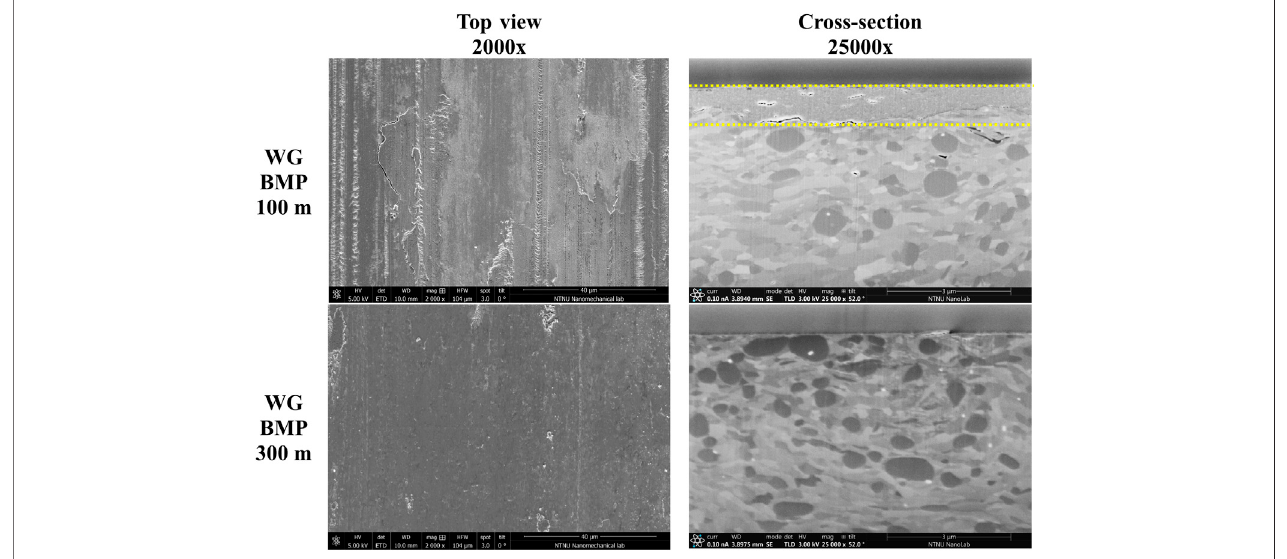
FIGURE4 | SEM topviewand SEM-FIBcross-section images ofthewear tracks on AISI 52100 steel disktested inWG-BMPlubricant for100 and 300 m at room temperature (tribo fi lm is indicated between two dashed yellow lines).